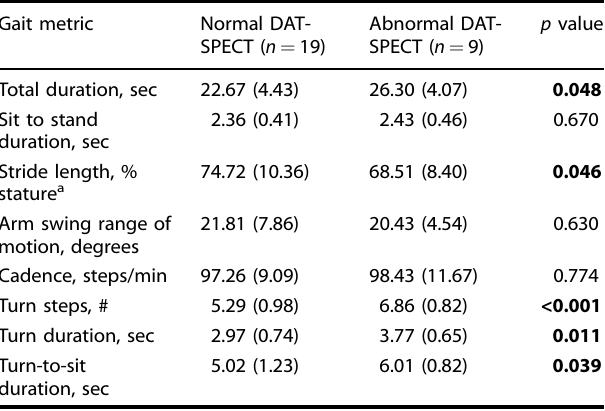
Table 4. Instrumented Timed Up and Go Test (iTUG) performance of DIP patients with normal and abnormal DAT ‐